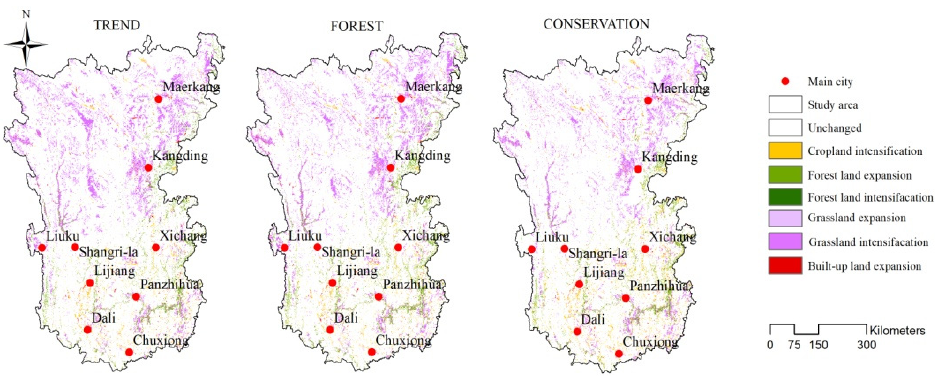
Figure 7. Spatial distribution of changes to the land system under different scenarios.